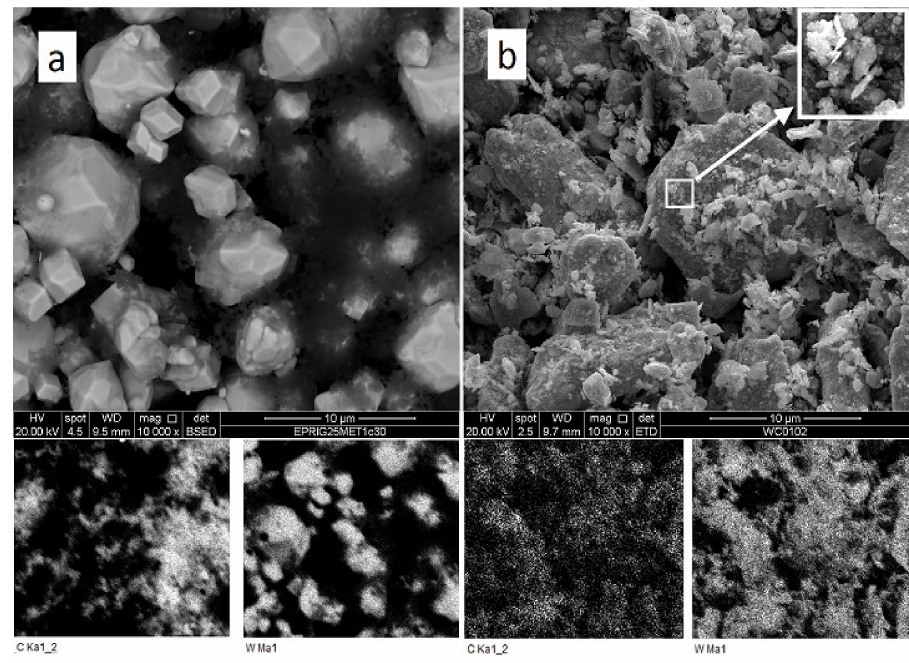
Figure 1. SEM and EDX analysis of as-mixed ( a ) and milled ( b ) W + 1.3% C powder.